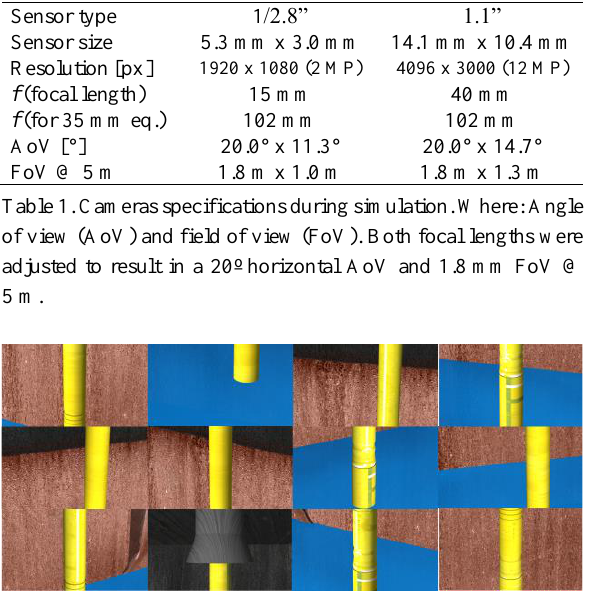
Figure 6. Example of the virtual dataset for riser